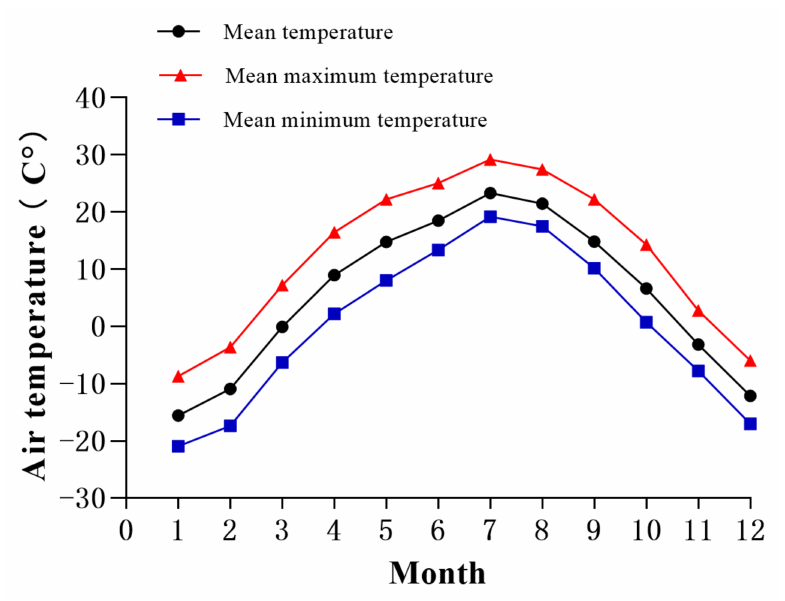
Figure 2. Monthly change in average temperature in Ganzi from 2016 to